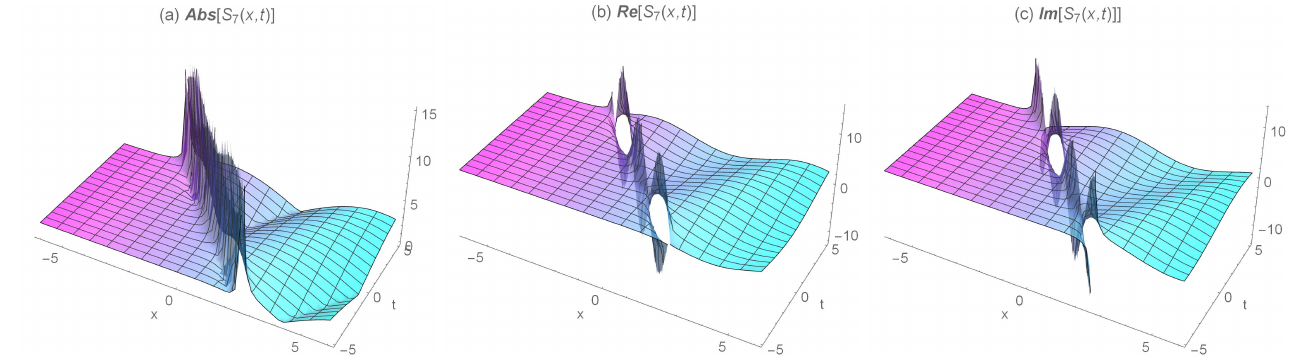
Figure 7. The 3D wave profiles for the absolute, real, and imaginary values of the singular kink soliton solution for b = 0.9, c = − 0.3, s = 1.5, k = 1, ϑ 0 = 0.2, ε 1 = 1, ε 2 = 1, ε 3 = 1.2, Ω = 0.5.